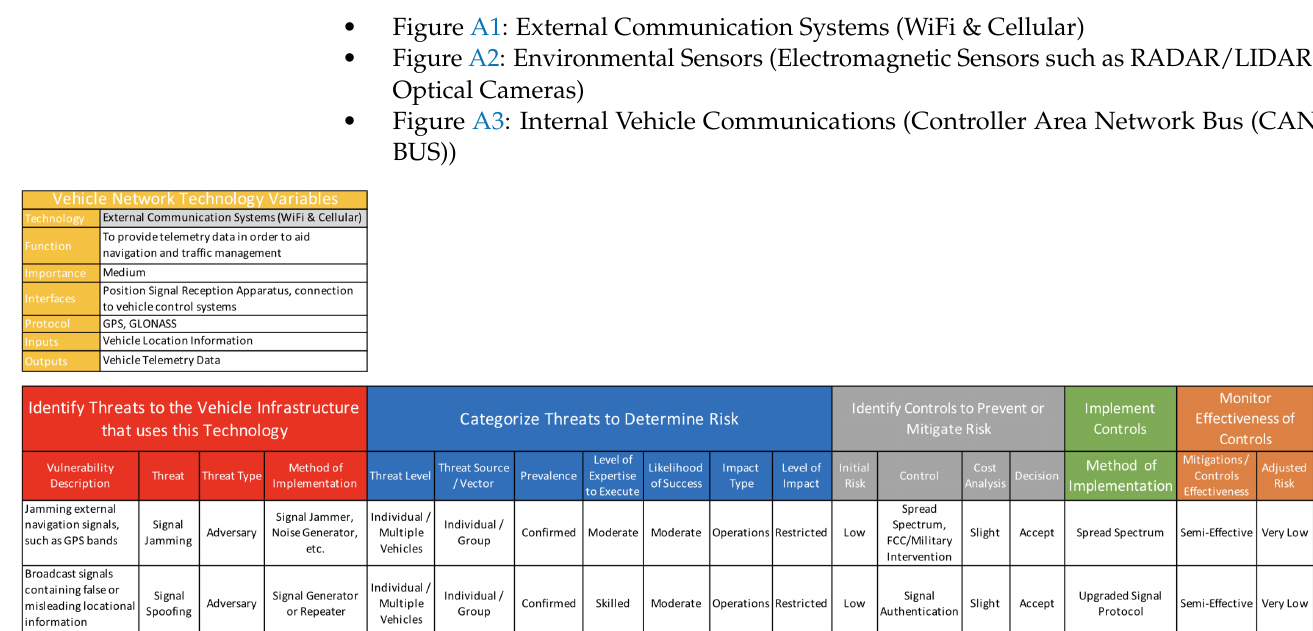
Figure A1: External Communication Systems (WiFi & Cellular) Figure A2: Environmental Sensors (Electromagnetic Sensors such as RADAR/LIDAR/ Figure A3: Internal Vehicle Communications (Controller Area Network Bus (CAN- BUS))